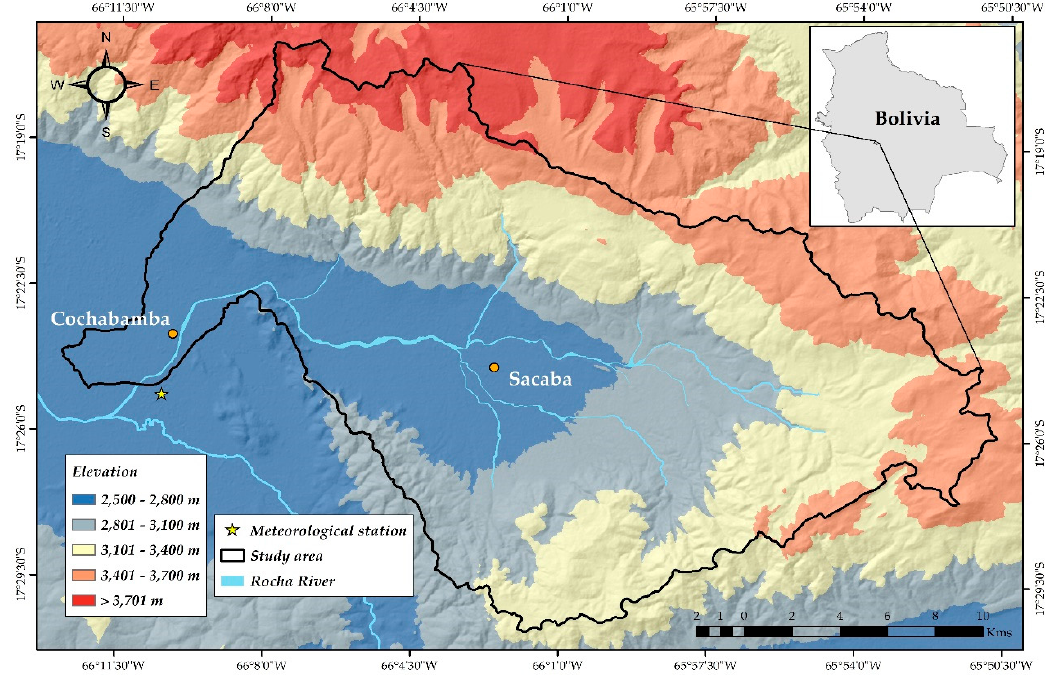
Figure 1. Location and topography of the Rocha River catchment.